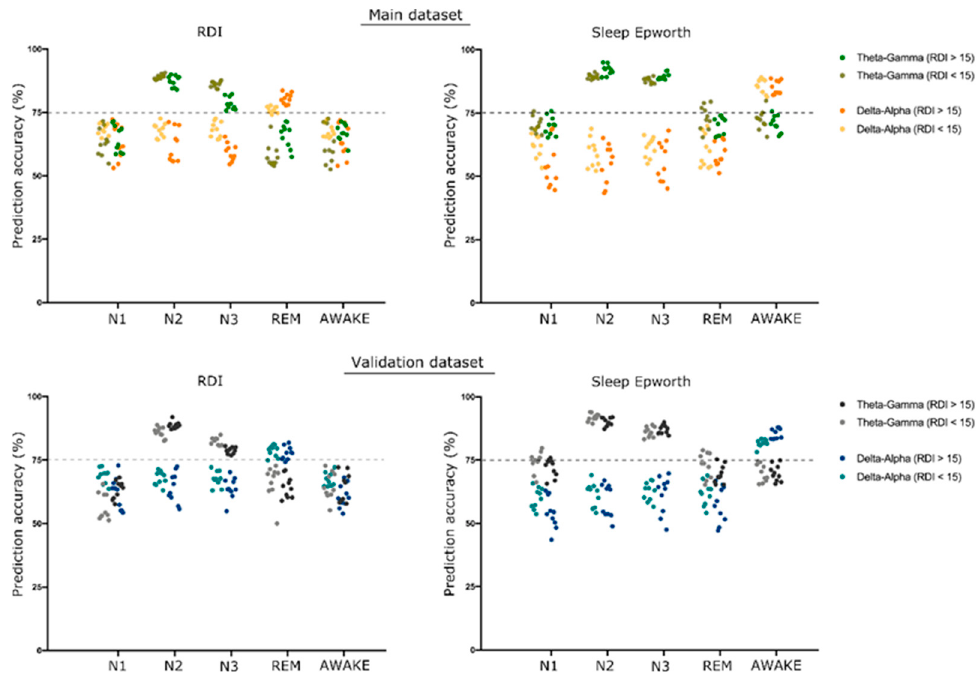
Figure 5. SVM prediction of RDI and ESS . The scatterplot shows the support vector machine (SVM) prediction accuracy of respiratory distress index (RDI) and Epworth Sleepiness Scale (ESS) using theta–gamma and delta–alpha cross-frequency coupling (CFC) modulation indices. A group of 10 dots in each set represents the accuracy obtained for 10-fold cross-validation. We considered accuracy above 75% to be significant, represented by a dotted line on the graph.